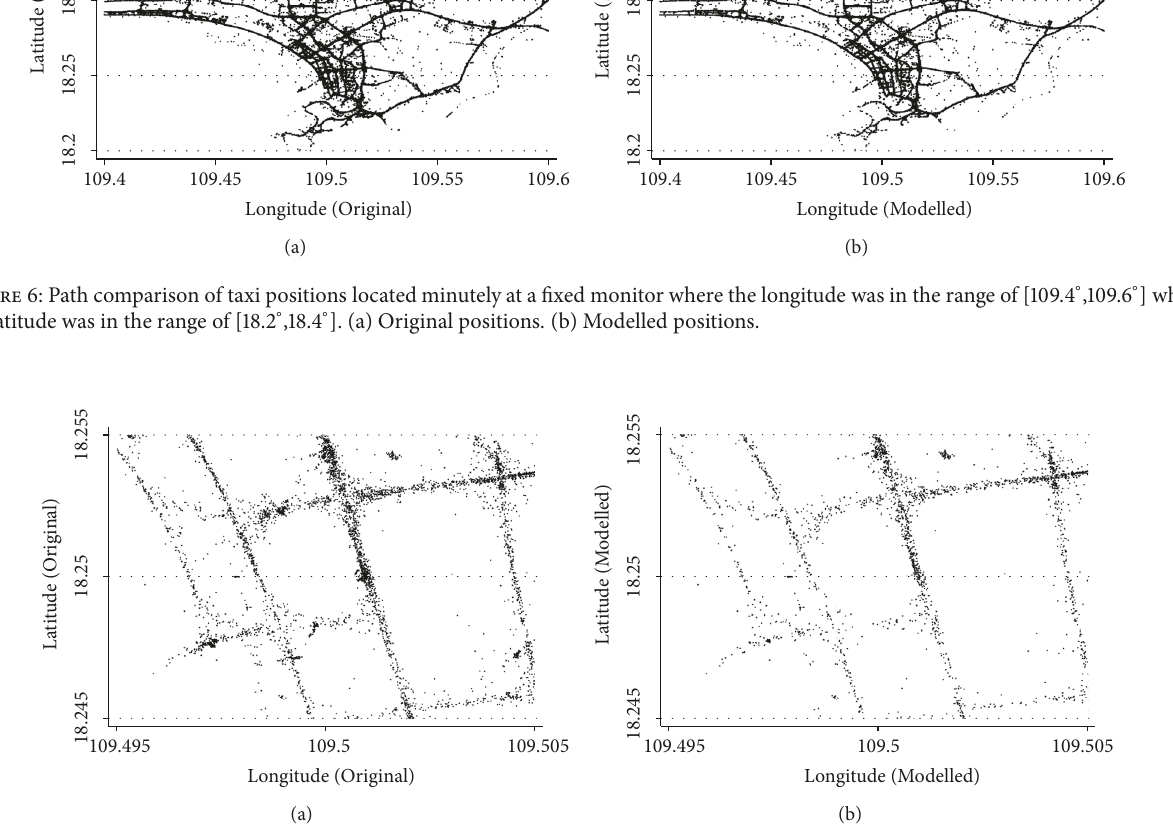
Figure 7: Path comparison of taxi positions located minutely at a fixed monitor where the longitude was in the range of [109.495 ∘ ,109.505 ∘ ] while the latitude was in the range of [18.245 ∘ ,18.255 ∘ ]. (a) Original positions. (b) Modelled